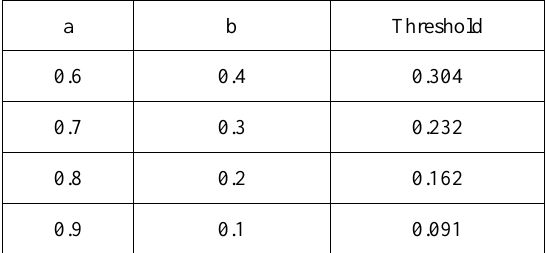
object. Region 2, region 3 、 region 4 and 5 all are excessive detection in figure 10 (a) and (b). For example, region 2